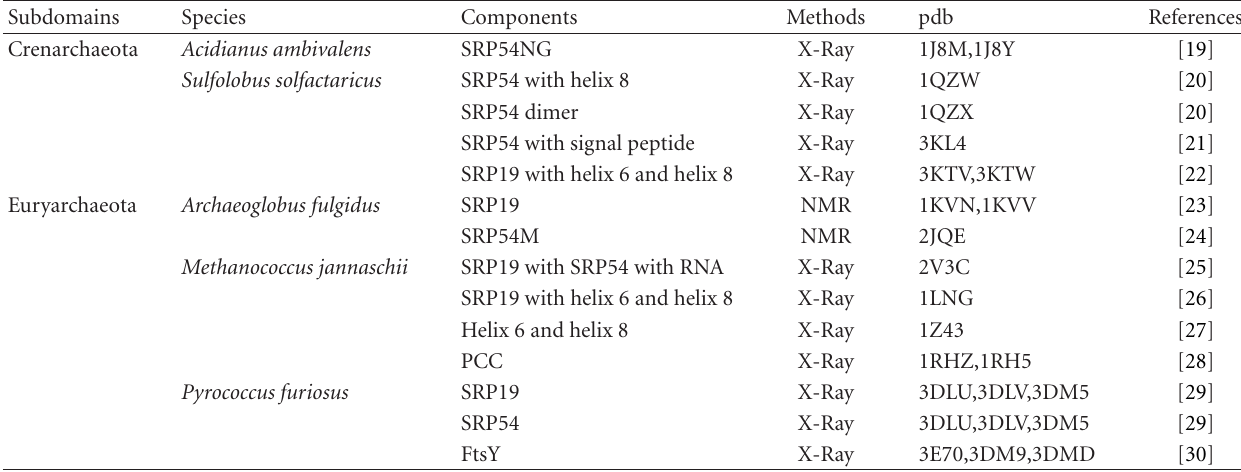
Table 1: High-resolution structures of archaeal SRP components. Indicated are the archaea subdomains (Crenarchaeota or Euryarchaeota), species names, components, and methods (X-Ray di ff raction of NMR) used for structure determination. The pdb IDs allow easy retrieval of the coordinates [18]. The protein-conducting channel is abbreviated as PCC. Additional nonarchaea SRP high-resolution structures are listed at http://rnp.uthct.edu/rnp/SRPDB/srpstructures.html.